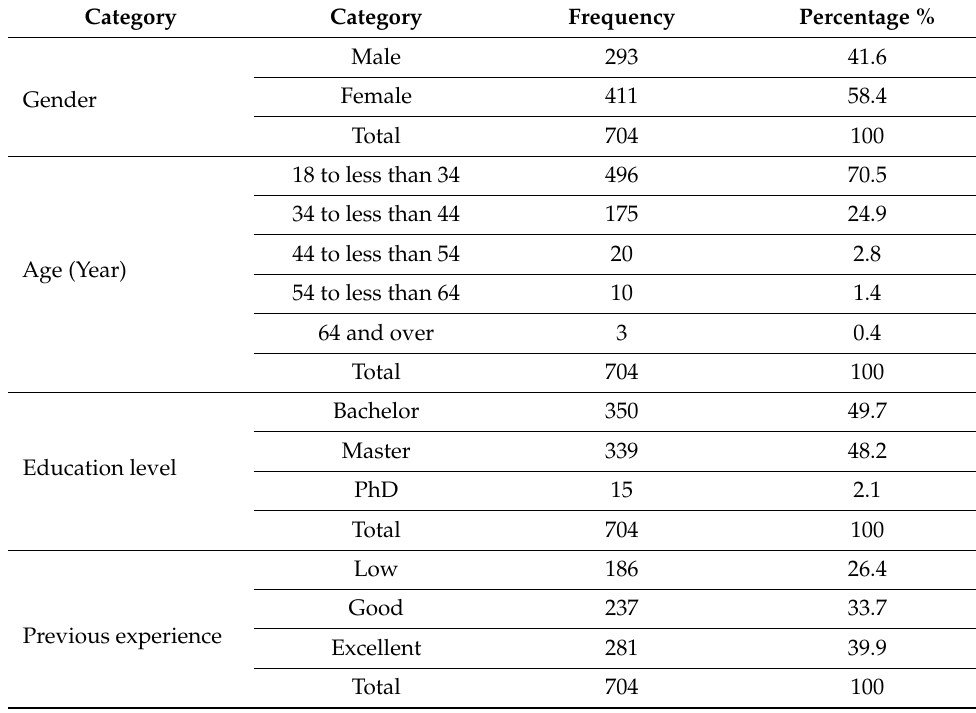
Table 1. Description of the respondents’ demographic